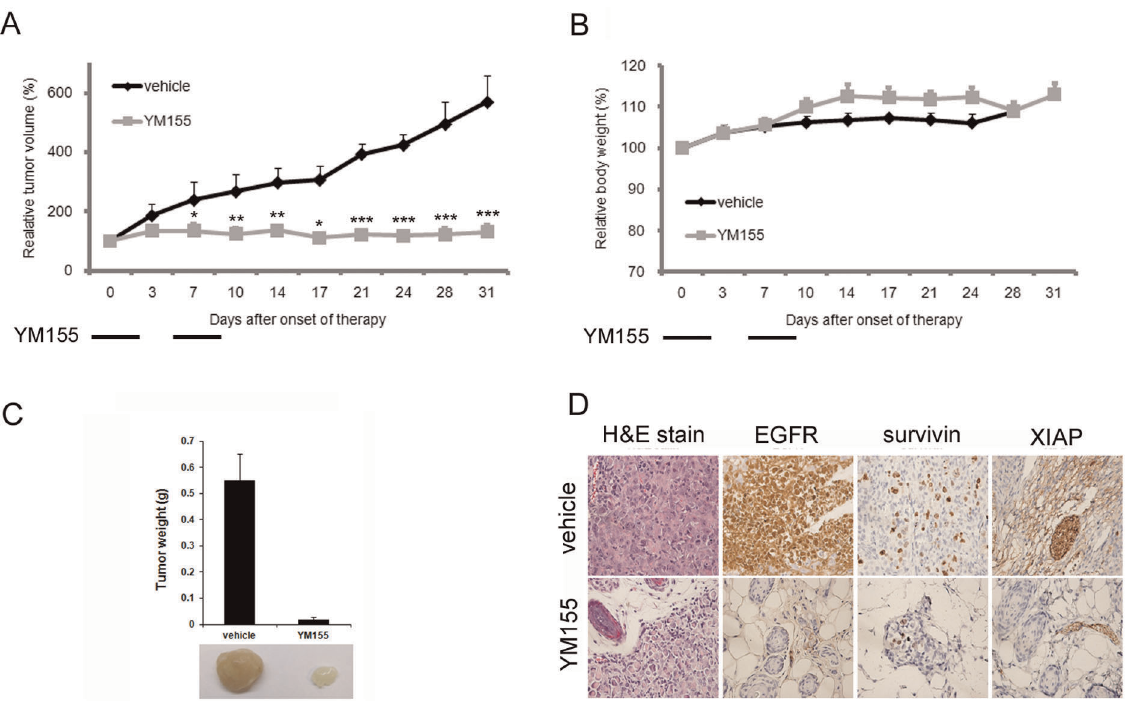
Figure 6. YM155 exhibits anti-tumor effects against pancreatic cancer invivo . Effects of YM155 on tumor growth (A) and body weight (B) in vivo were evaluated in MIAPaCa-2 xenografts (vehicle, n=6; YM155, n=8). Tumor volume was determined at the indicated times after the onset of treatment. YM155 was administered at dose of 50 mg/kg. The in vivo experimental schedule of YM155 is indicated at the bottom of each graph. Day 0 indicates the time at which subcutaneous tumors reached a size of 100 mm 3 and administration of YM155 was started. Statistical analyses of the effects of YM155 on tumor size were performed using Mann-Whitney tests (*p , 0.05, **p , 0.01, ***p , 0.001, YM155 vs. vehicle). C, Average tumor sizes are depicted for each group on day 31. D, Immunohistochemical analyses in xenograft tumors on day 31 after the YM155 treatment were performed using antibodies against EGFR, survivin, and XIAP and stained with H&E.